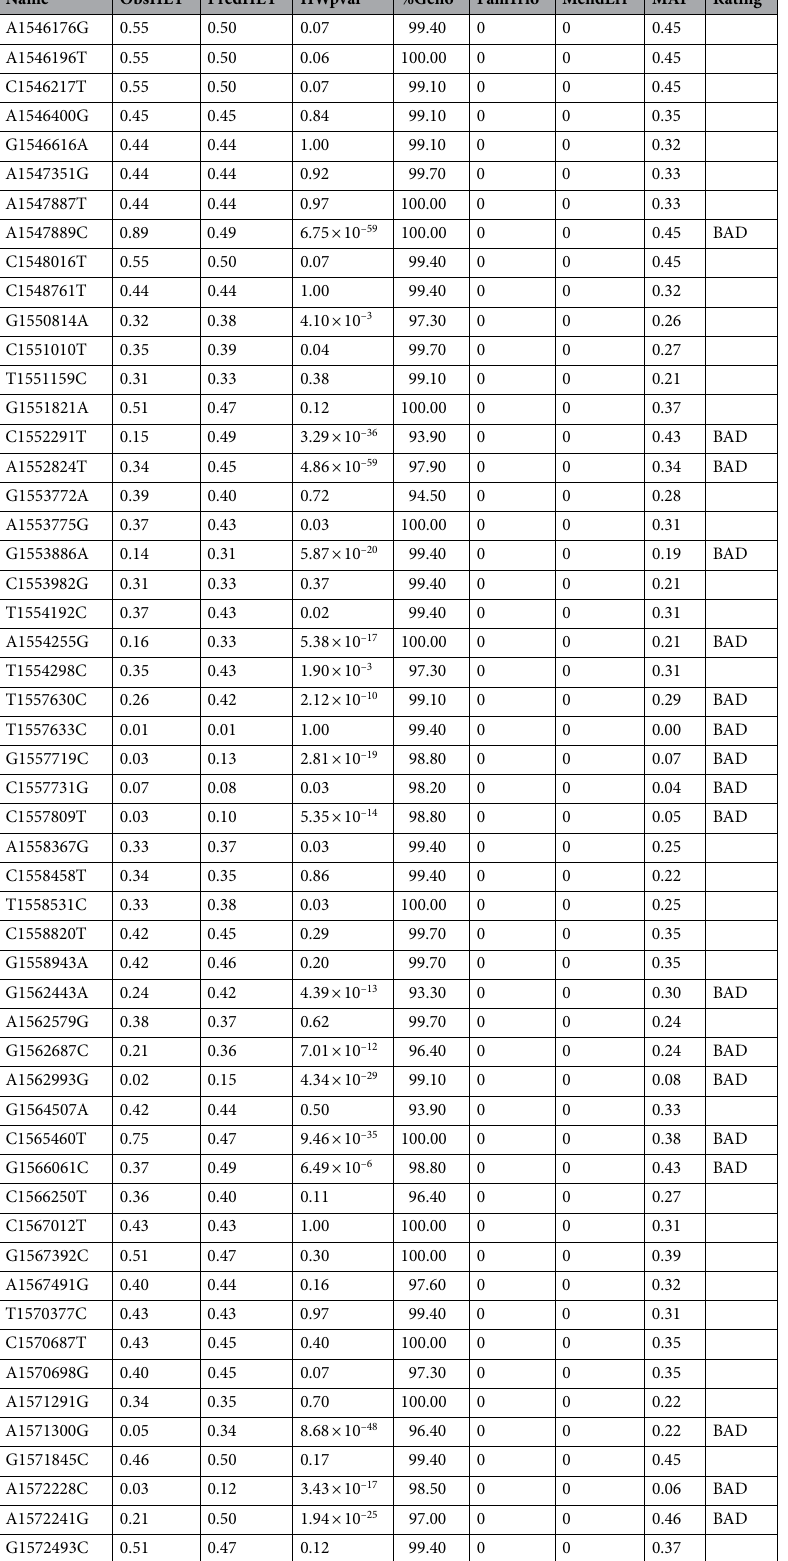
Table 2. Quality control filtering result of SNPs. ObsHET the SNP’s observed heterozygosity, PredHET the SNP’s predicted heterozygosity, HWpval Hardy–Weinberg equilibrium P value, %Geno the percentage of non- missing genotypes for the SNPs, FamTrio the number of fully genotyped family trios for the SNPs, MendErr the number of observed Mendelian inheritance error, MAF minimum allele